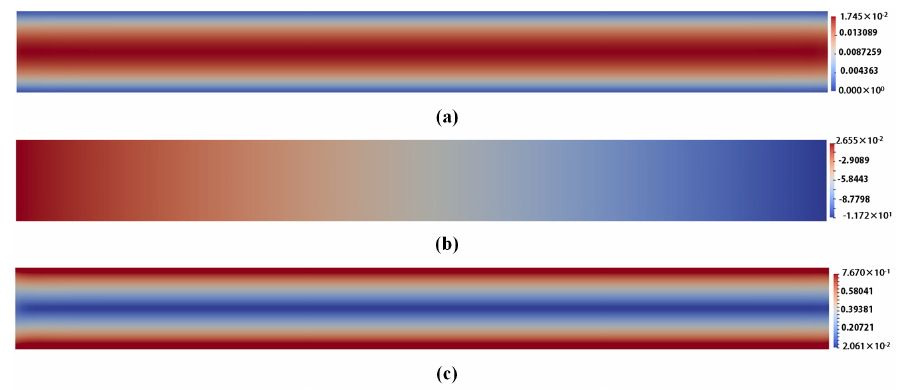
Figure 6. The snapshots: ( a ) of the velocity field uuu for FENE model with l = 2, ρ = 0.1, N BCF = 800, b = 100 at t = 1.999185; ( b ) of the pressure field p for FENE model with l = 2, ρ = 0.1, N BCF = 800, b = 100 at t = 1.999185; and ( c ) of the stress tensor field τττ p for FENE model with l = 2, ρ = 0.1, N BCF = 800, b = 100 at t =